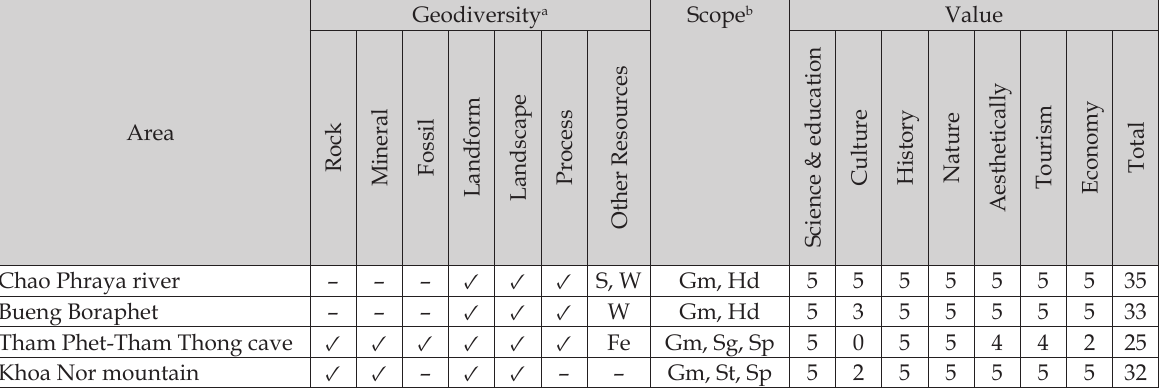
Table 2. Classification and Assessment of the Geoheritage in Nakhon Sawan, Thailand.